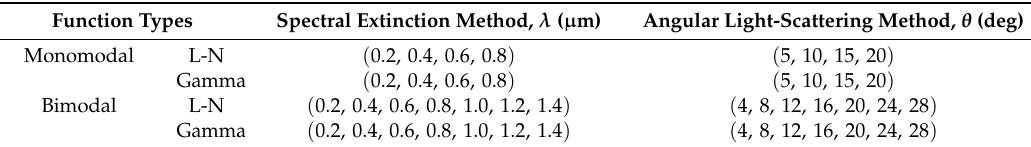
Table 2. The measurement wavelengths and angles for retrieval of ASDs.